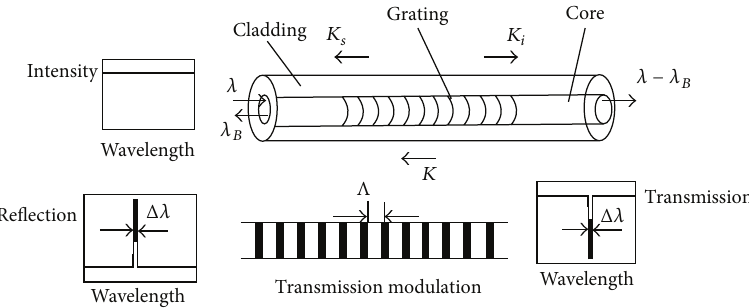
Figure 1: Refractive index distributions of FBG and transmission and reflection characters.